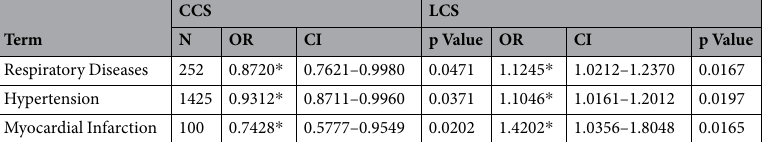
Table 4. Statistics for average number of cigarettes smoked per day for those aged between 56 and 80 years. ‘ * ’Indicates p < 0.05. Results that approach significance are indicated with the symbol ‘”. The unit of CCS and LCS is 10 cigarettes per